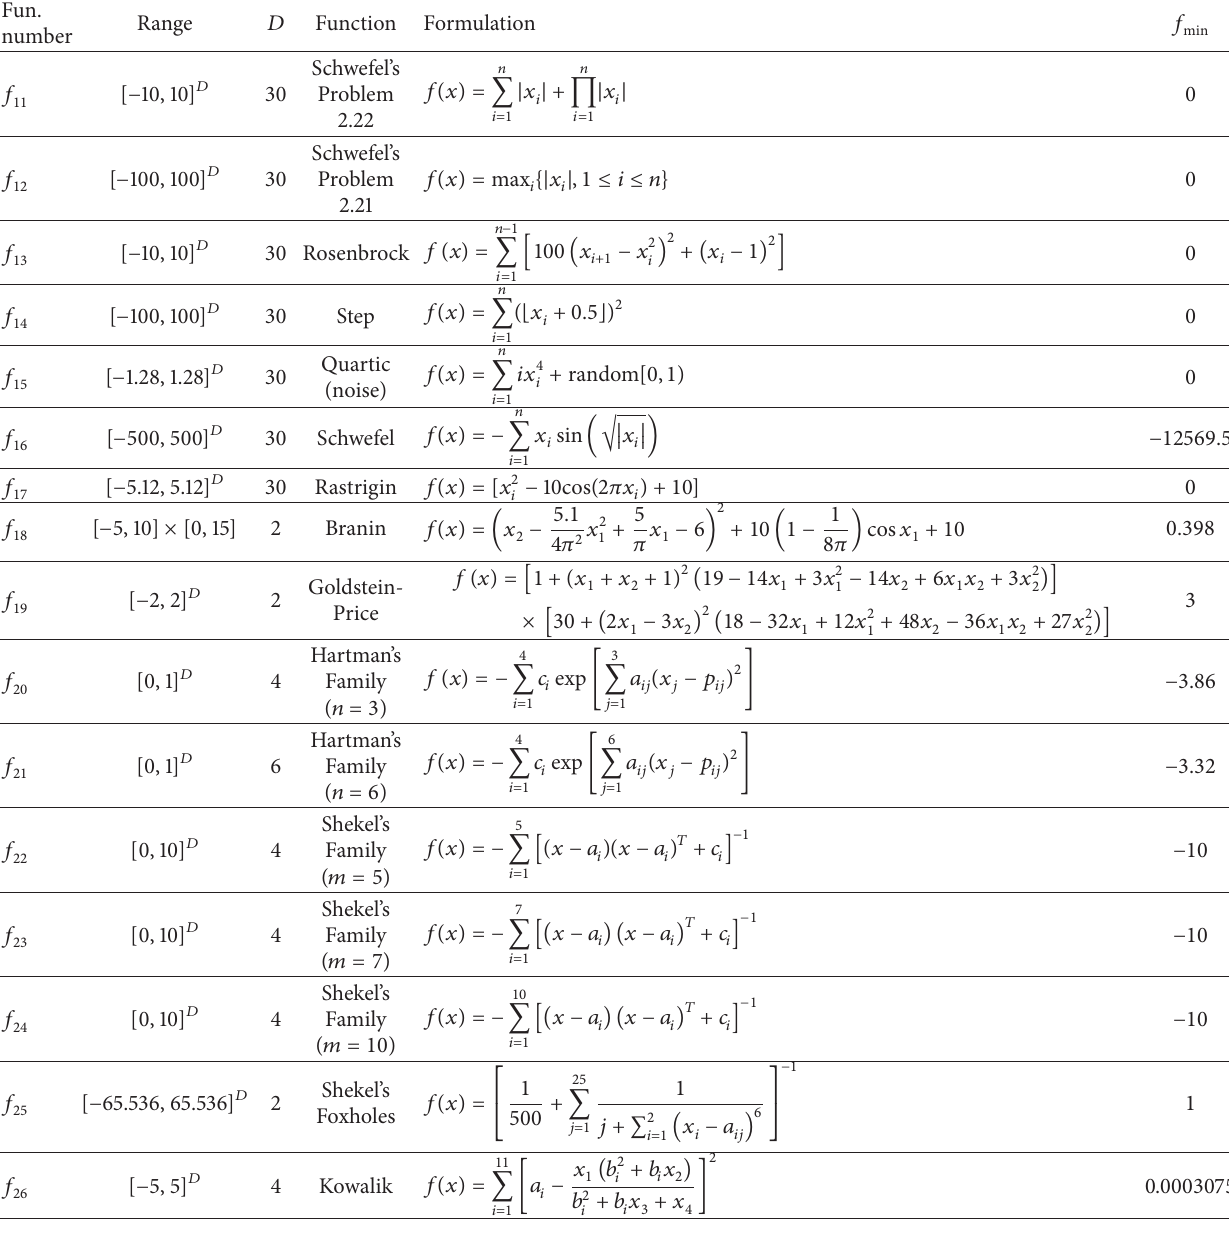
Table 9: Unconstrained global optimization problems (Set-2) used in our experiments [30].